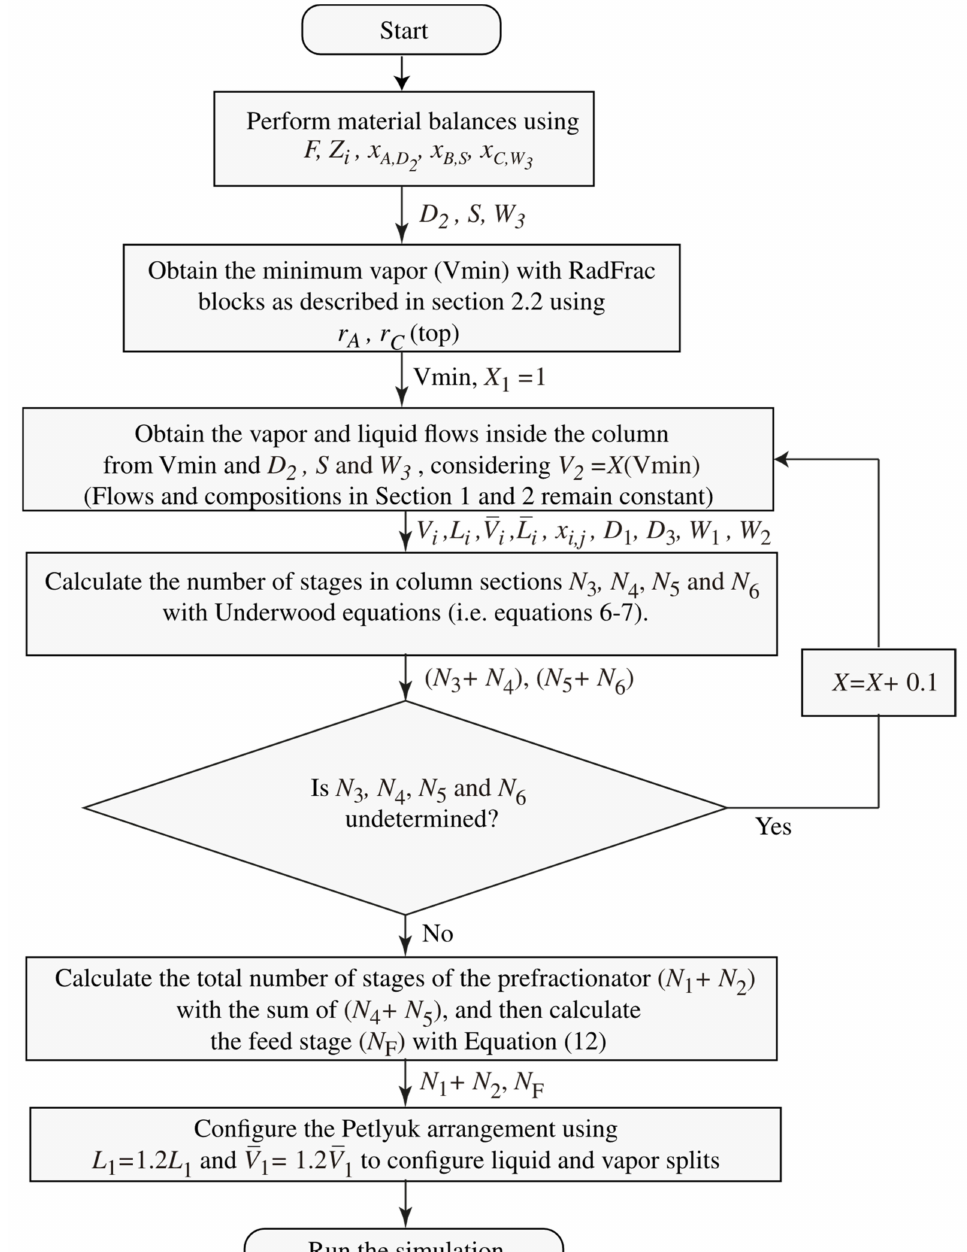
Figure 7. Proposed design methodology for